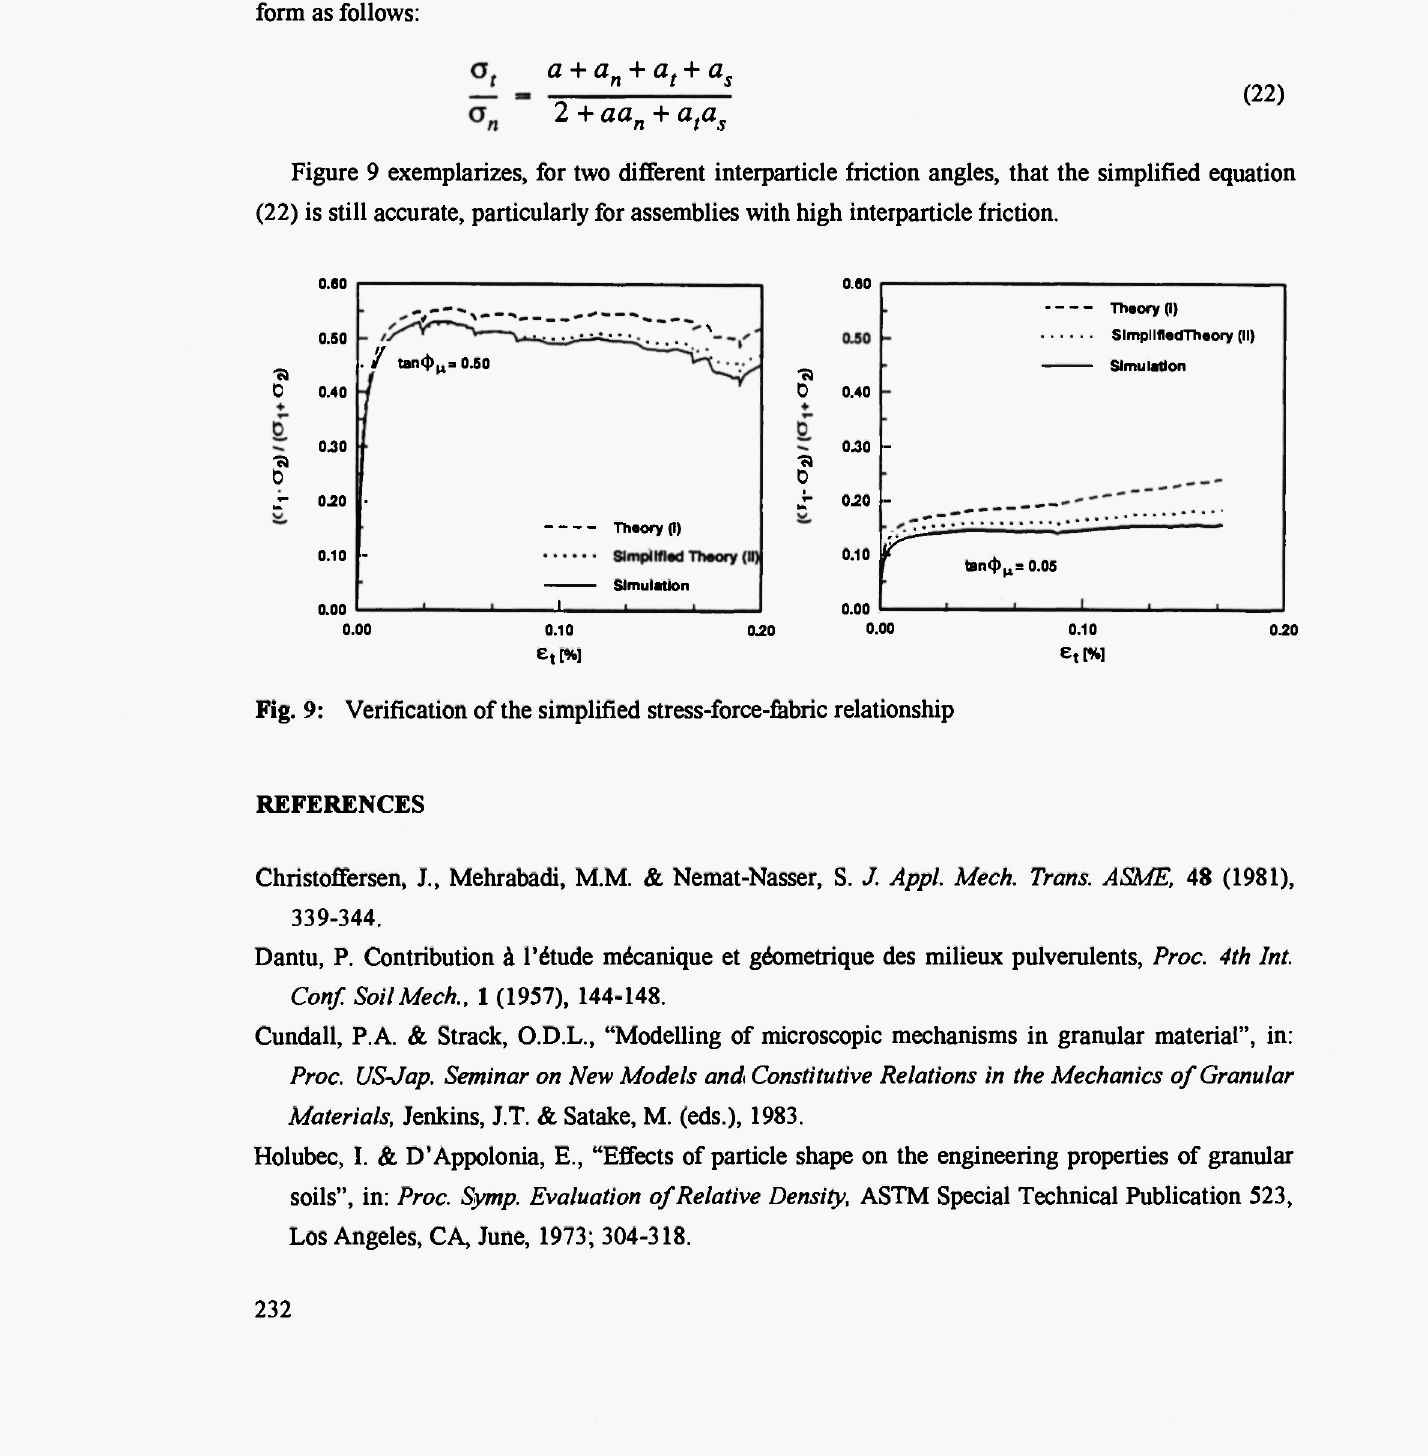
Figure 9 exemplarizes, for two different interparticle friction angles, that the simplified equation (22) is still accurate, particularly for assemblies with high interparticle friction.